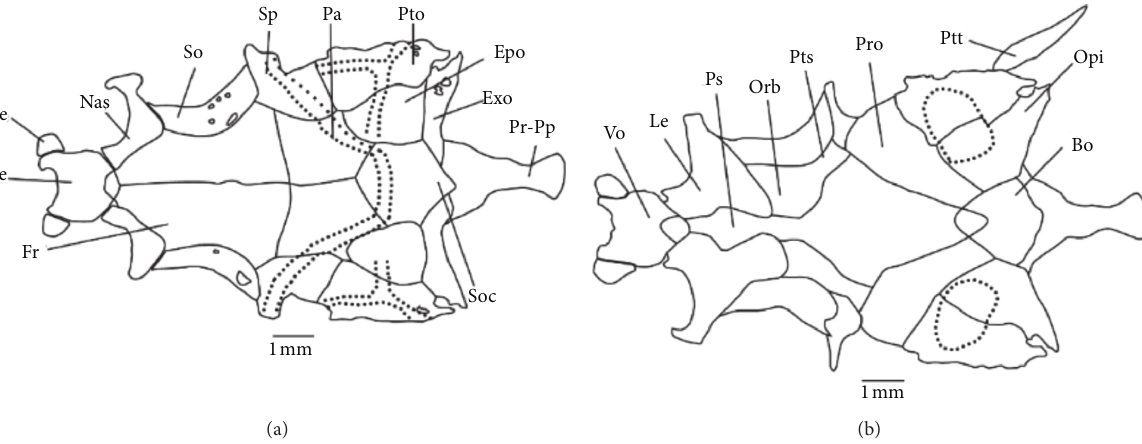
Figure 1: (a) Dorsal and (b) ventral views of the neurocranium in G. rossica . Bo: basioccipital; Epo: epiotic; Exo: exoccipital; Fr: frontal; Nas: nasal; Orb: orbitosphenoid; Pa: parietal; Pe: preethmoid-I; Ptt: posttemporal; Pr-Pp: posterior pharyngeal process; Pro: prootic; Ps: parasphenoid; Pts: pterosphenoid; Pto: pterotic; Se: supraethmoid; So: supraorbital; Soc: supraoccipital; Sp: sphenotic; Vo: